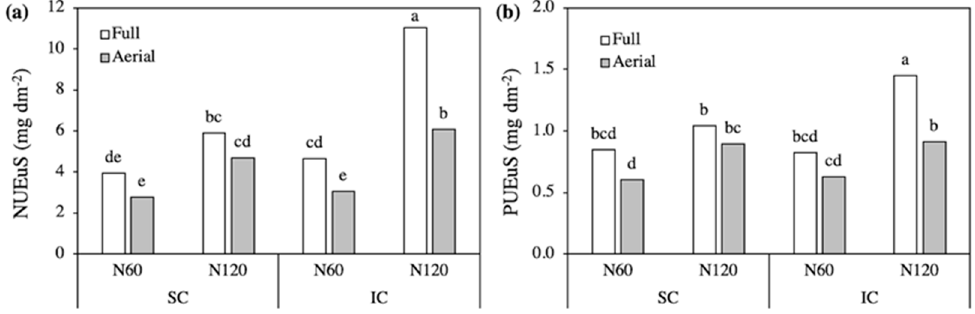
Figure 6. Nitrogen (NUEuS, a ) and phosphorus (PUEuS, b ) uptake efficiency per unit of root surface in triticale, as affected by the Crop system × N level × Row contact interaction. SC, sole crop; IC, intercrop. Values are the mean of three replicates. In each figure, bars with different letters indicate that the corresponding means are significantly different at P < 0.05, Tukey’s test.